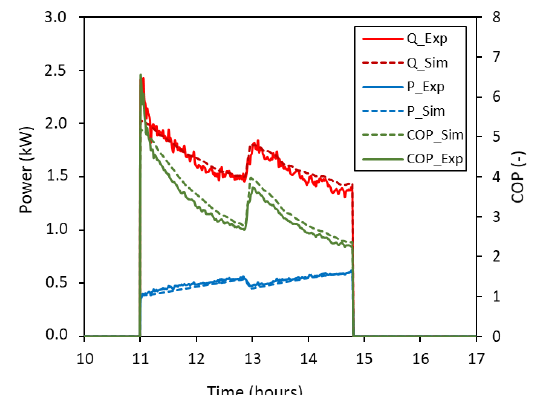
Figure 10. Heat pump useful thermal power (Q), power consumption (P), and coefficient of perfor- mance ( COP ) during tank stratification cycles. Experimental vs. numerical results for TC3 3 × 33